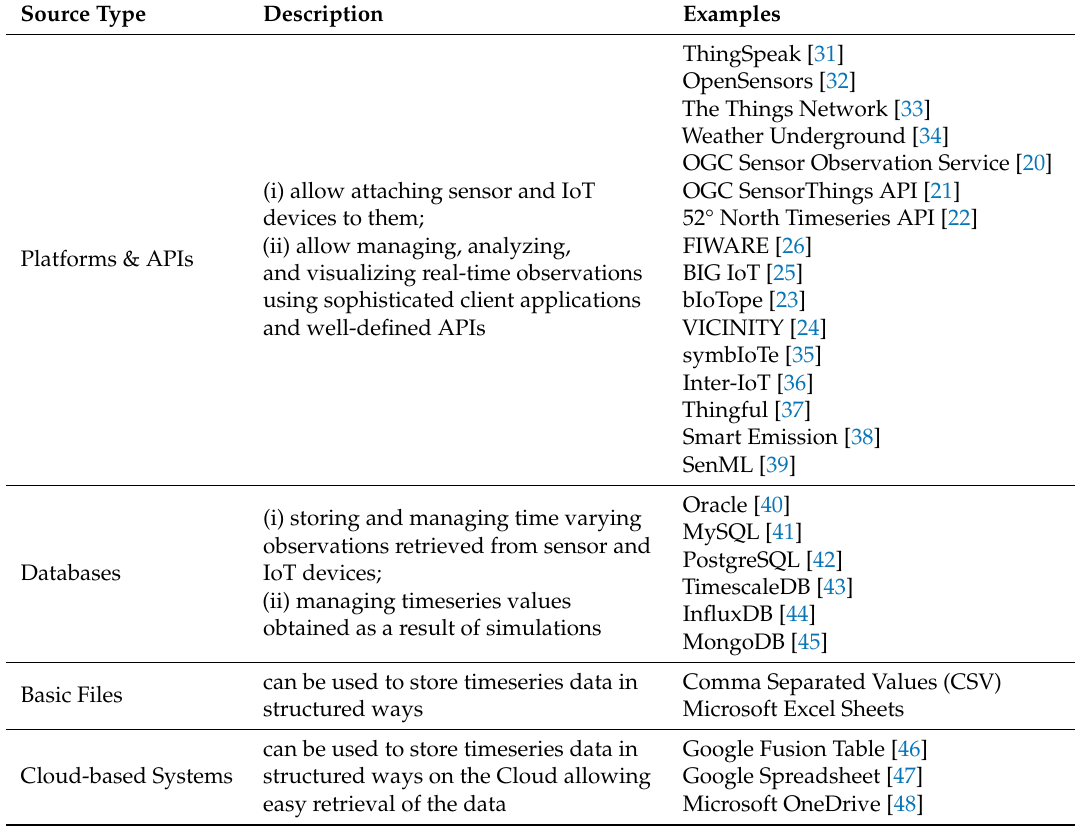
Table 1. Overview of different types of data sources which are used for storing, managing, and accessing timeseries data for diverse